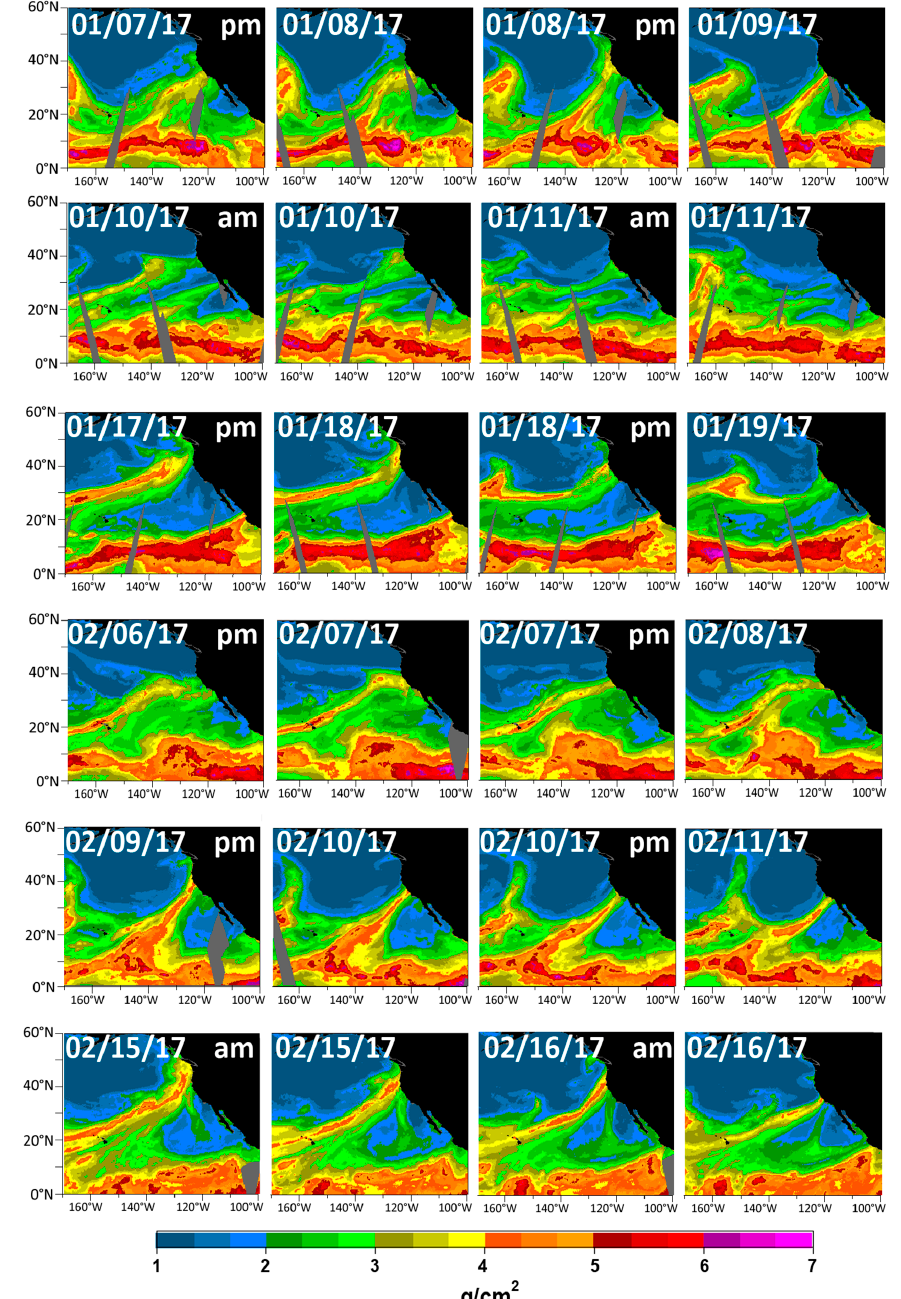
Figure 4. The Special Sensor Microwave Imager Sounder (SSMIS) integrated water vapor (IWV) 0.25° grid spacing and average twice daily from 0–12Z (AM) and 12–24Z (PM) for four AR events, 01/07–11, 01/17–19, 02/06–10, 02/15–21 of 2017. Examples of AR events that occurred during these time periods are shown. Water vapor amounts above at least 4 g/cm 2 (>2 cm [7]) represents an AR.